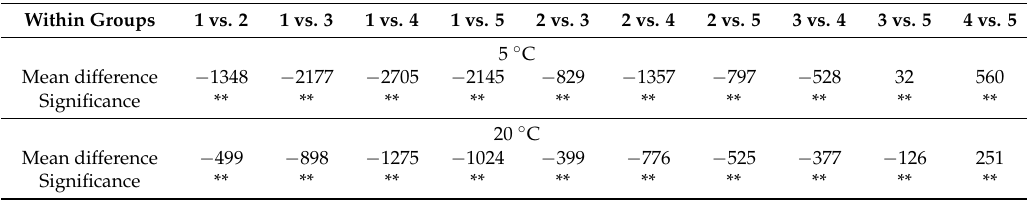
Table 9. Tukey’s HSD test results for low-temperature